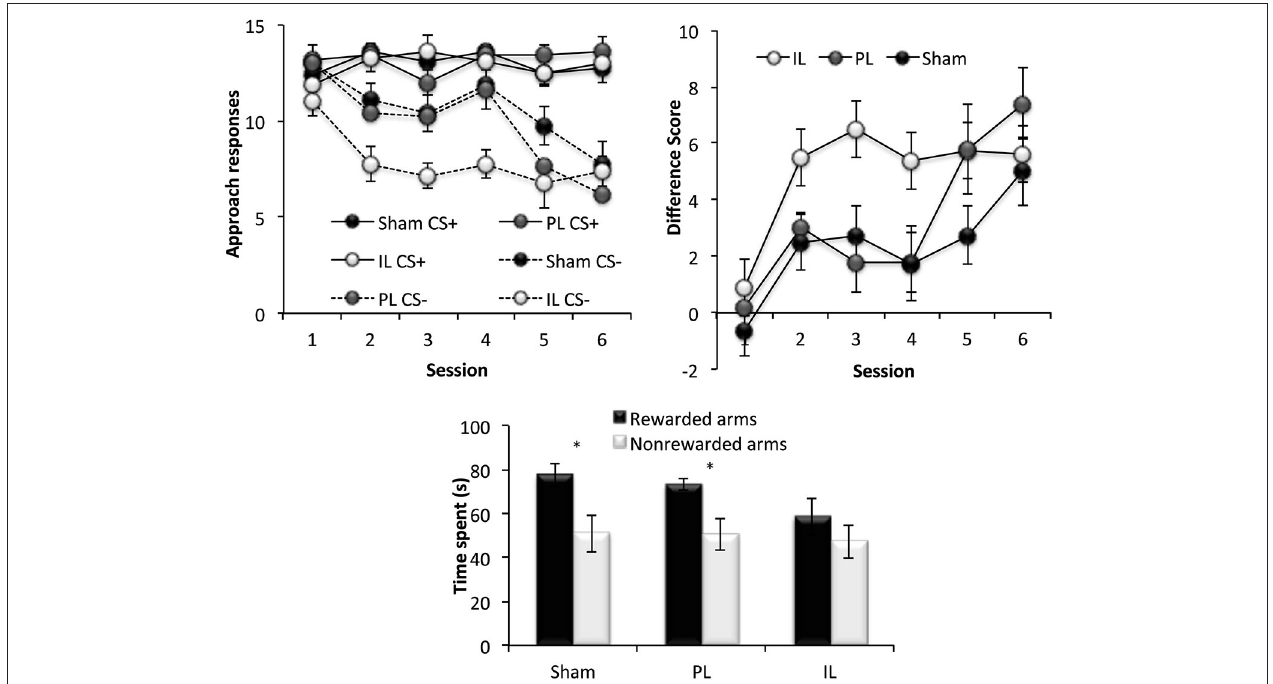
The lower panel shows the second conditioned place preference test expressed as the mean ± SEM time spent in the 3 rewarded or 3 non-rewarded arms in a 5 min session. * p < 0.05, ** p < 0.01 difference between time spent in rewarded vs. non-rewarded